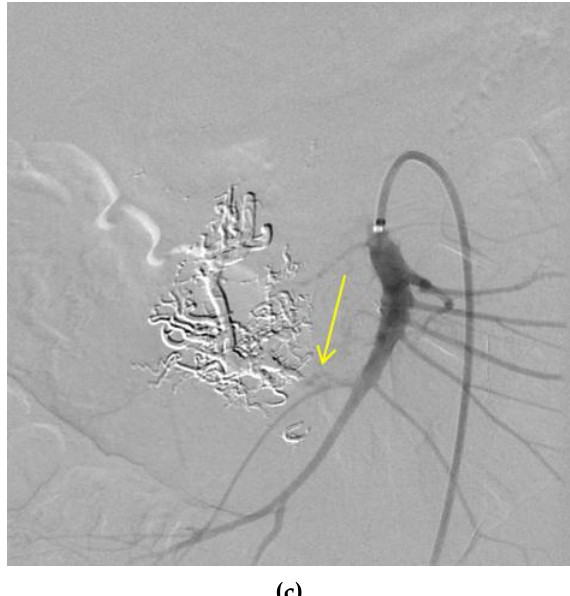
Figure 4. Embolization of a pancreatic AVM. Onyx is used to occlude a nidus with feeder arteries from both the gastroduodenal and superior mesenteric (SMA) arteries. Draining vessels include the superior mesenteric vein (SMV) and portal veins. ( a ) The image shows the presence of a spongiform nidus, with a “blush” of arteriole-venule connections, indicative of a Cho–Do type IIIa or Yakes type II AVM. ( b ) The image from a common hepatic artery digital subtraction arteriogram (DSA) shows the occlusion of gastroduodenal artery feeders; and ( c ) The image from an SMA DSA shows occlusion of SMA feeders. The liquid embolic agent has hardened and is dense (subtracted in these images) due to the addition of tantalum powder for radiographic visualization.